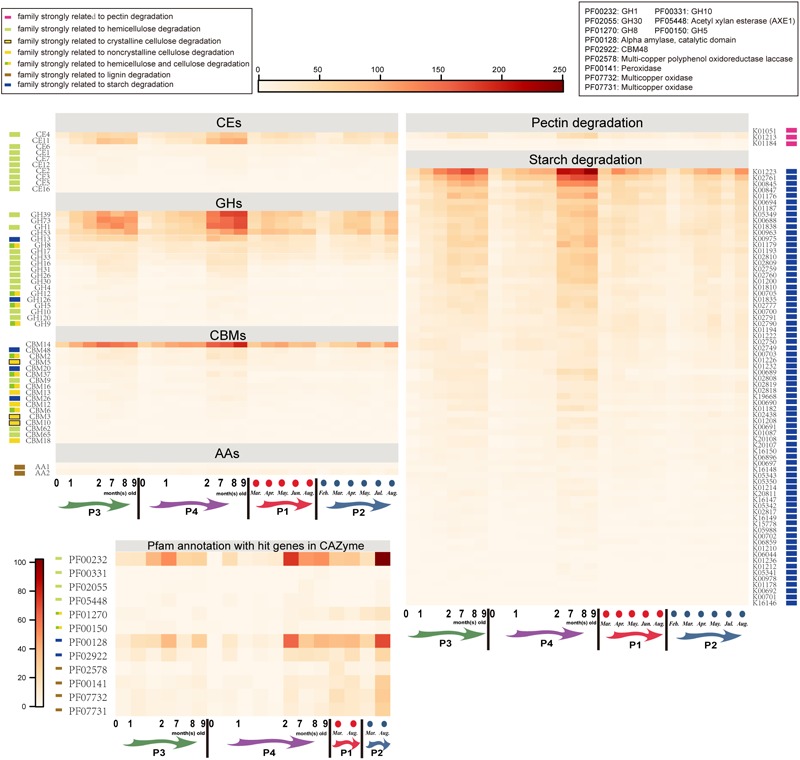
Abundance of microbial genes involved in bamboo digestion in the gut of cubs and their parents. Carbohydrate esterases (CEs), glycoside hydrolases (GHs), carbohydrate-binding modules (CBMs) and auxiliary activity (AAs) genes were annotated using the CAZy database; pectin degradation genes and starch degradation genes were annotated using the KEGG database. The genes matched in the CAZy database were further annotated in the Pfam database, to confirm the gene function, and only the abundances of bamboo-digesting genes were shown in the Pfam annotation results. P1: father; P2: mother; P3: elder cub; P4: younger cub.